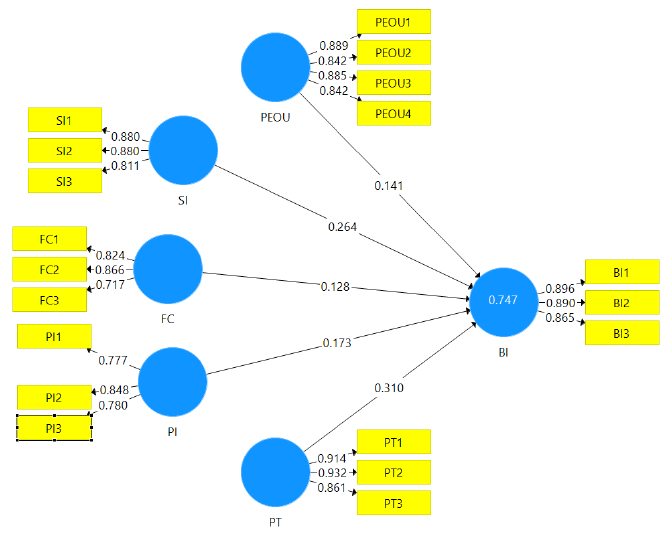
Figure 2. R 2 Value . Source: SMART PLS Analysis Result. Figure 2. R 2 Value. Source: SMART PLS Analysis